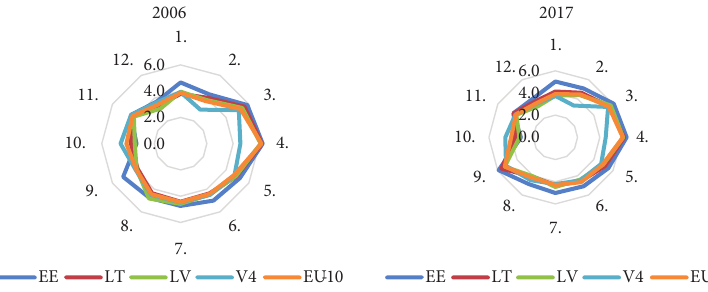
Figure 3. Pilars of the competitive positions of the Baltic States (against the backdrop of the V4 countries and the EU-10) in 2006 and